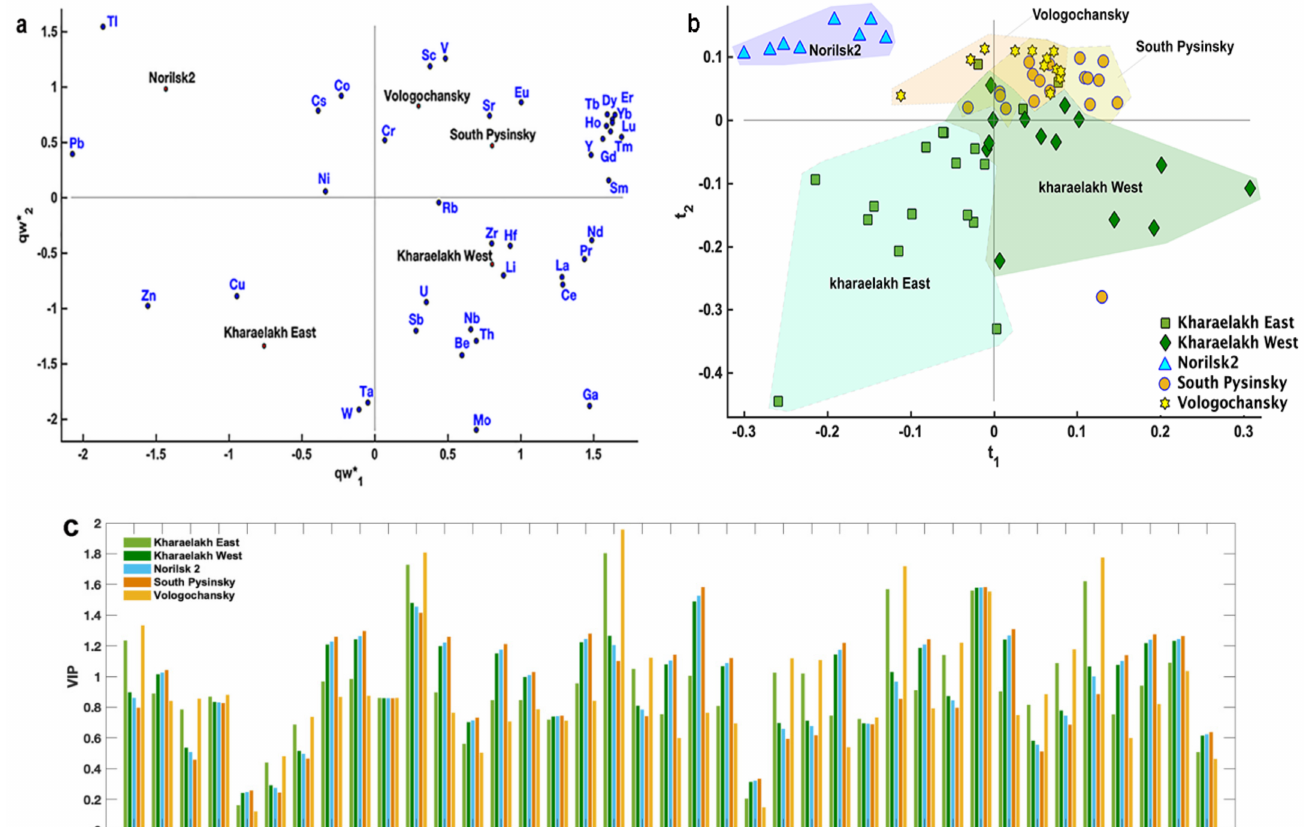
Figure 12. Partial least-squares discriminant analysis (PLS-DA) of the trace and minor elements data in the samples from the different studied gabbro–dolerite intrusions. ( a ) The qw* 1 –qw* 2 (first and second loadings) biplot, ( b ) respective t 1 –t 2 plot, and ( c ) variable importance on projection (VIP)